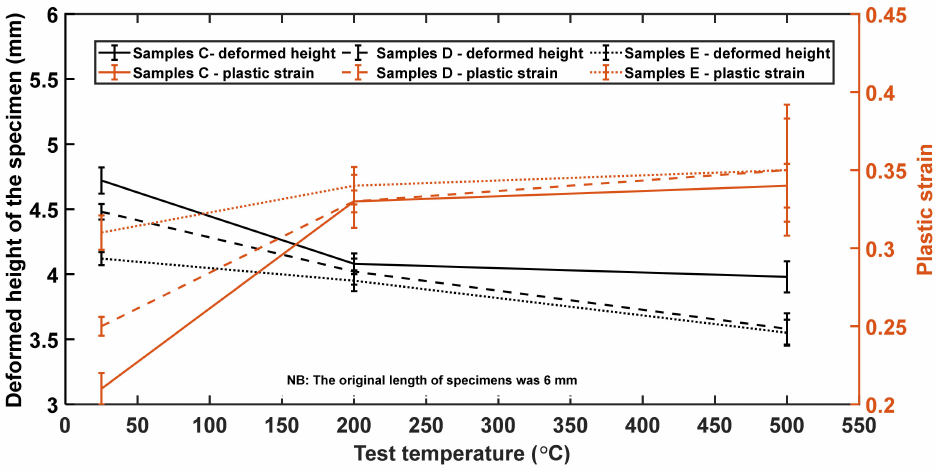
Figure 19. The measured height of deformed specimens and estimated longitudinal plastic strain at a strain rate of 2450 s − 1 and different temperatures for samples C, D, and